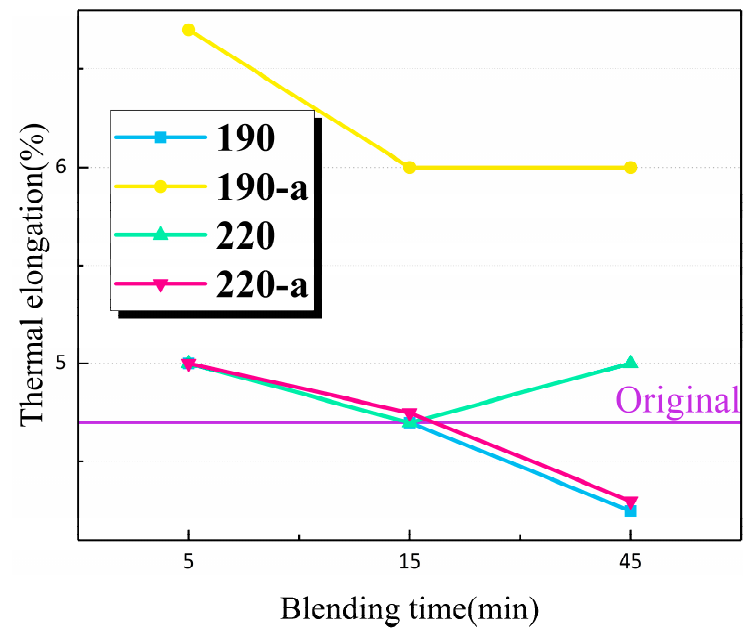
Figure 5. The thermal elongation of each sample under different shear at 150 °C.